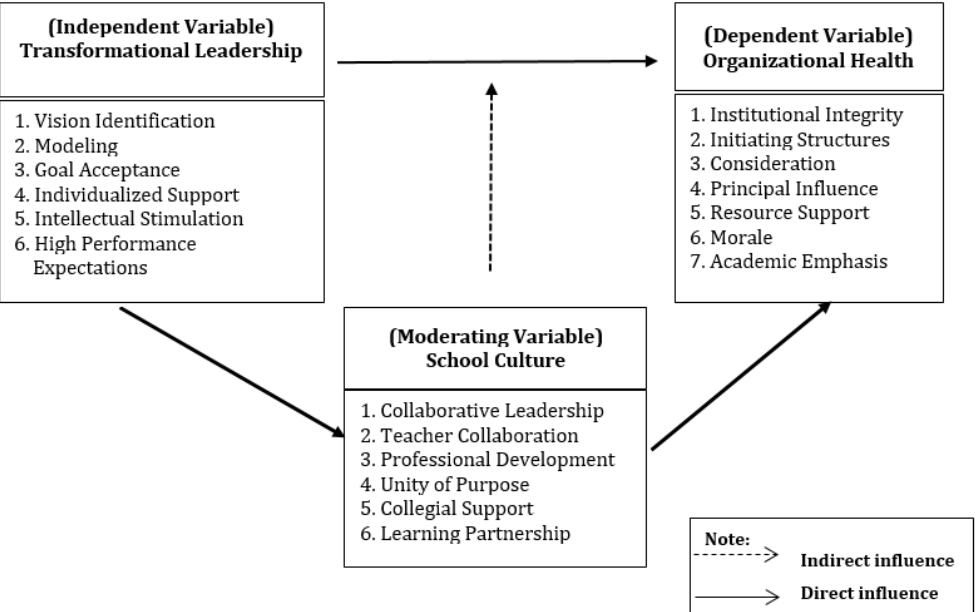
Figure 1: The Conceptual Framework Based on Transformational Leadership